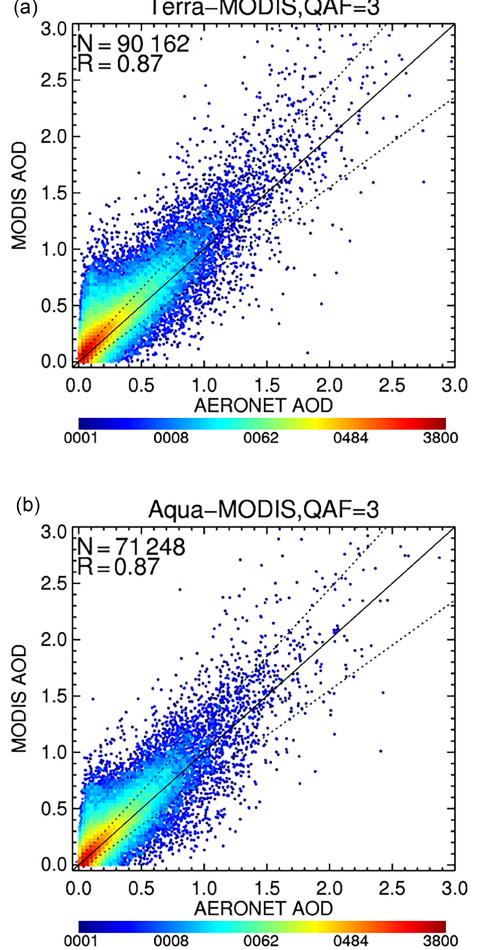
Figure 2. Two-dimensional density scatterplot of MODIS 3km AOD versus AERONET-observed AOD at 0.55µm for the global collocation data set. Panel (a) is for Terra MODIS for only the re- trievals identified as “high quality” (QAF = 3), and panel (b) is for Aqua MODIS for QAF = 3. The solid line denotes the 1 : 1 line, and the dashed lines denote the envelope of the expected error (EE), defined by Eq. (2).